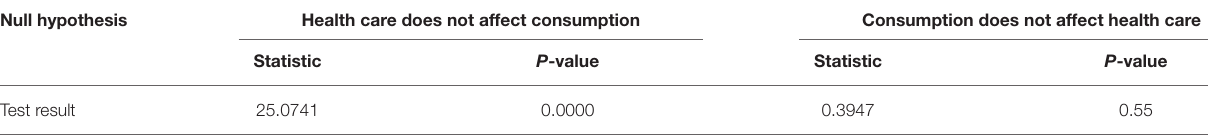
TABLE 1 | Granger causality test for the whole sample of boots.